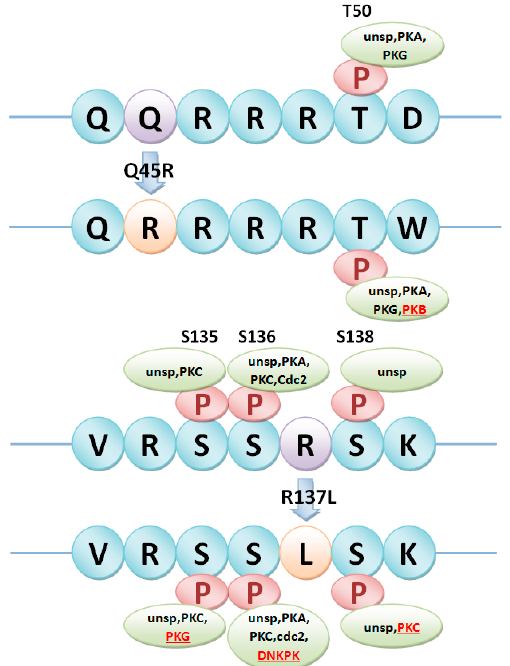
Figure 6. Two Type III phosSNPs, Q45R and R137L, in heterotrimericG γ 2 subunit (LOC_Os02g04520), which changed the kinase types in the adjacent protein phosphorylation sites of T50, S135, S136 and S138. PKA: Protein kinase A; PKB: Protein kinase B; PKC: Protein kinase C; PKG: Protein kinase G; Cdc2: Cell division cycle 2 kinase; DNKPK: DNA-Dependent Protein Kinase; unsp: non-specific prediction kinase.